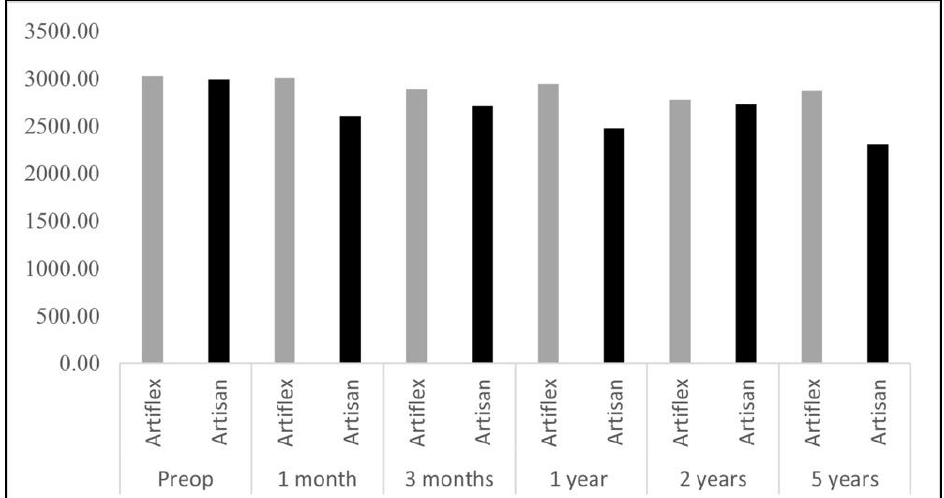
Figure 1. Endothelial cells accounts mean.